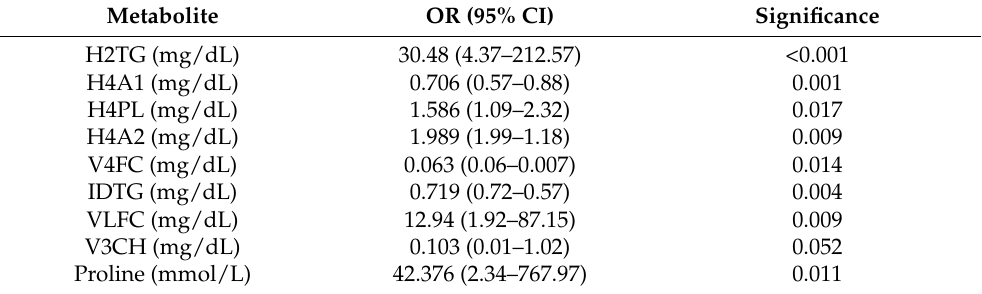
Table 4. Differences in metabolic profile between fast progressors and nonfast progressors in patients who had a liver biopsy.